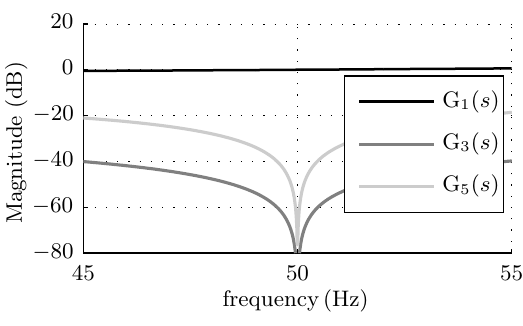
Figure 3. Magnitude response of G 1 ( s ) , G 3 ( s ) and G 5 ( s )